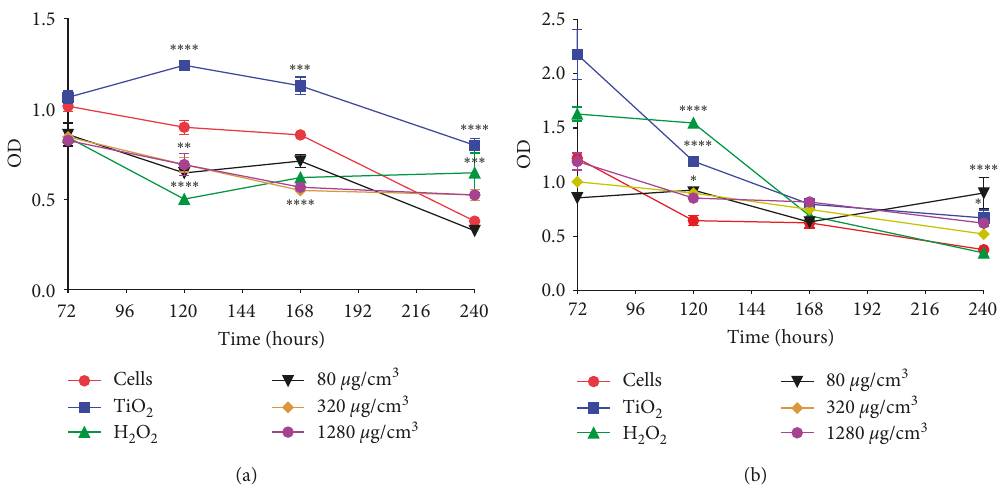
Figure 6: Cell viability, as assessed by MTTassay, of Pichincha volcanic ash in (a) A549 and (b) McCoy cells with ash treatments after 72, 120, 168, and 240 hours. The monolayer cell cultures were exposed to 80 µ g/cm 3 (black), 320 µ g/cm 3 (yellow), and 1280 µ g/cm 3 (purple) of volcanic ash and 400 µ g/cm 3 titanium dioxide (blue). The negative control (red) was cell without any treatment. 0 . 01 (two- way ANOVA with Dunnett’s posttest).